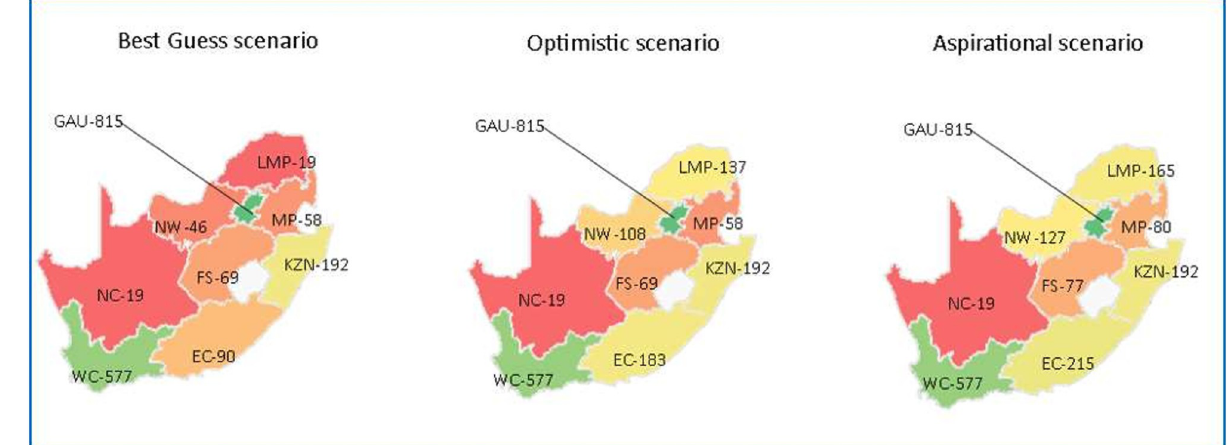
Fig 5. National shortfall for dentists and dental specialists per province based on three scenarios. Gauteng (GAU); KwaZulu-Natal (KZN); North West (NW); Western Cape (WC); Eastern Cape (EC); Free State (FS); Limpopo (LMP); Mpumalanga (MP); Northern Cape (NC).